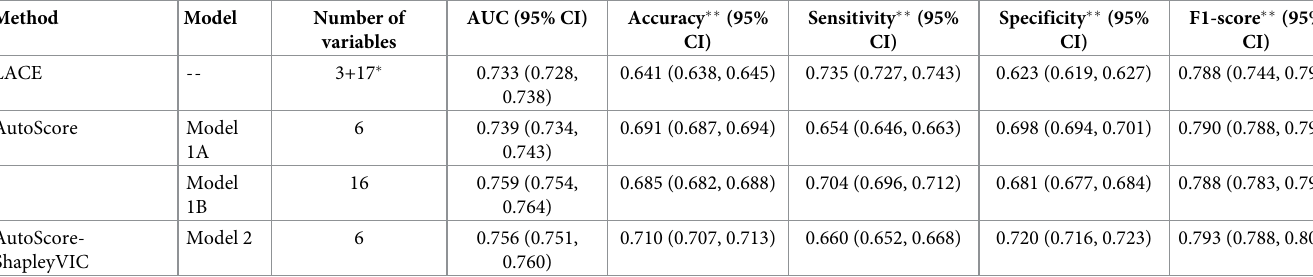
Table 2. Model performance evaluated on the test set.